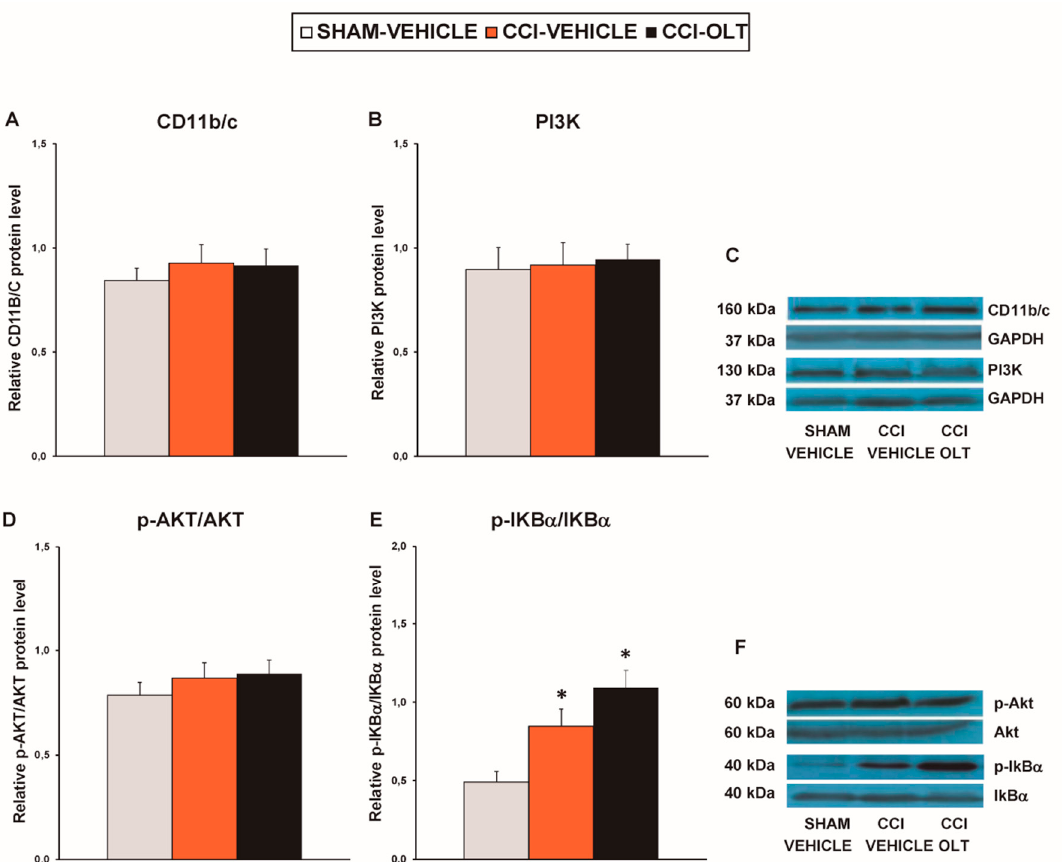
Figure 8. Effects of oltipraz on the expression of CD11b/c, PI3K, p-Akt, and p-IkB α in the prefrontal cortex of the CCI-injured mice. The relative protein levels of ( A ) CD11b/c, ( B ) PI3K, ( D ) p-Akt, and ( E ) p-IKB α in the prefrontal cortex of the CCI-injured mice treated with oltipraz (OLT) or vehicle. The sham-operated mice (SHAM) treated with vehicle were used as controls. Representative examples of blots for ( C ) CD11b/c (160 kDa), PI3K (130 kDa) and GAPDH (37 kDa), and for ( F ) p-Akt (60 kDa), Akt (60 kDa), p-IKB α (40 kDa) and IKB α (40 kDa). CD11b/c and PI3K are expressed relative to GAPDH levels whereas phosphorylated proteins are expressed relative to their corresponding total proteins. In all panels, * denotes significant di ff erences vs. sham-operated mice treated with vehicle ( p < 0.05; one-way ANOVA followed by the SNK test). Results are presented as the mean ± SEM; n = 4–5 samples per experimental group.